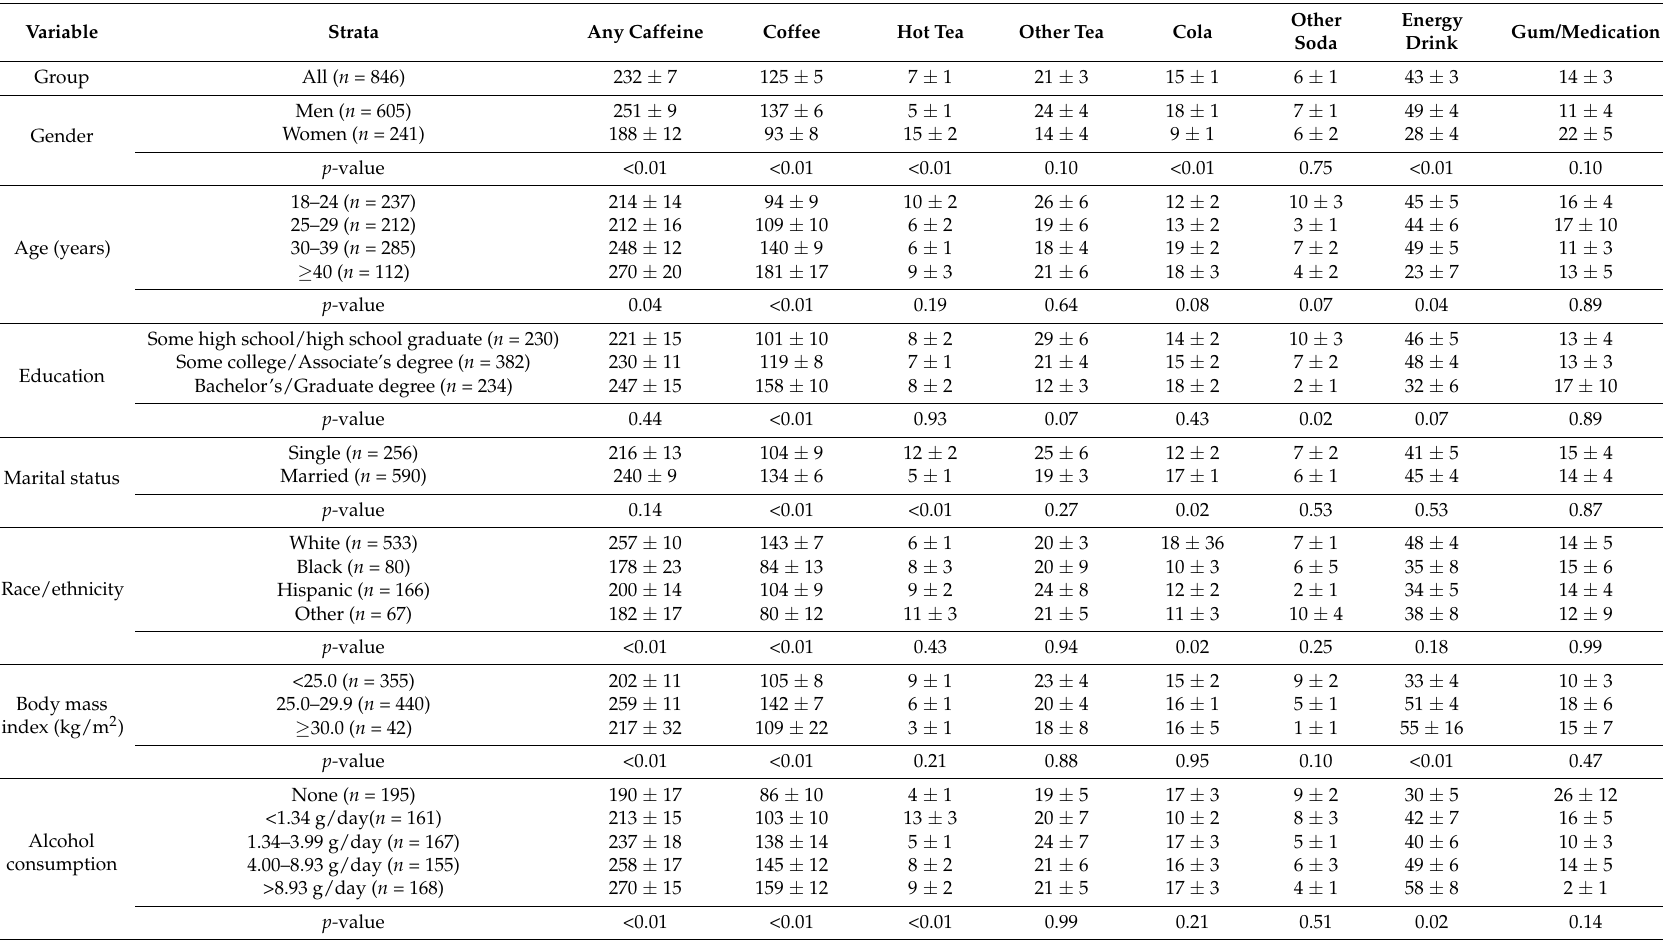
Table 5. Caffeine consumption (mean ± SE mg/day) of Marine Corps consumers ( ≥ 1 time/week) by demographic, lifestyle, and military characteristics ( p -values are from one-way analysis of